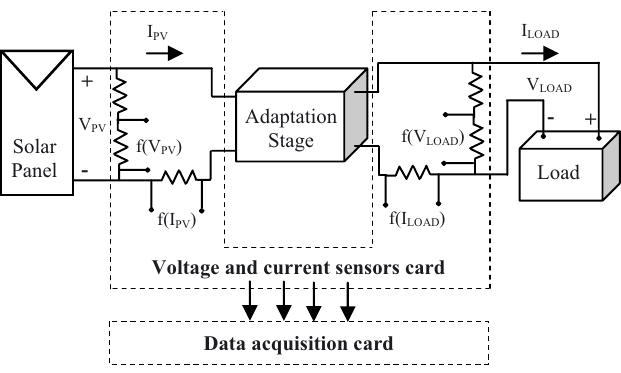
Fig. 4. Schematic representation of photovoltaic conversion chain test bench.